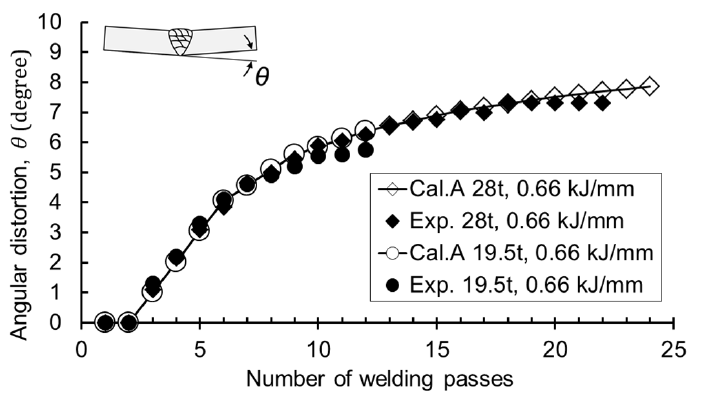
Figure 12. Results of angular distortion with different thicknesses.